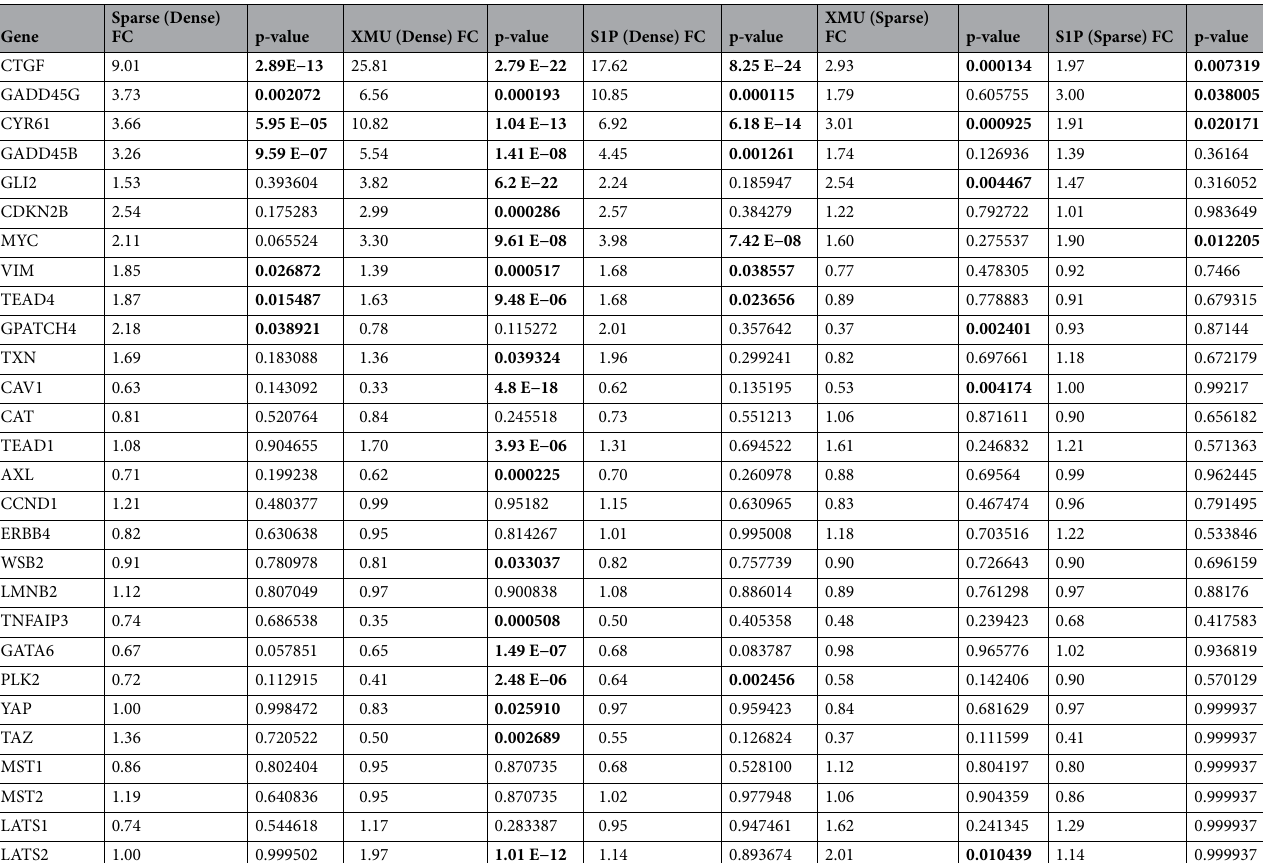
Table 1. RNASeq results of YAP target gene expression. FC fold change. The comparisons are made between the first treatment (outside of the parentheses, listed first) and the second (Inside the parentheses). A fold change greater than 1 indicates in increase in gene expression in the first treatment type compared to the second, and a fold change greater than 1 indicates a decrease in gene expression in the first treatment type compared to the second. p-values were obtained as in the methods. Bold values indicate significant